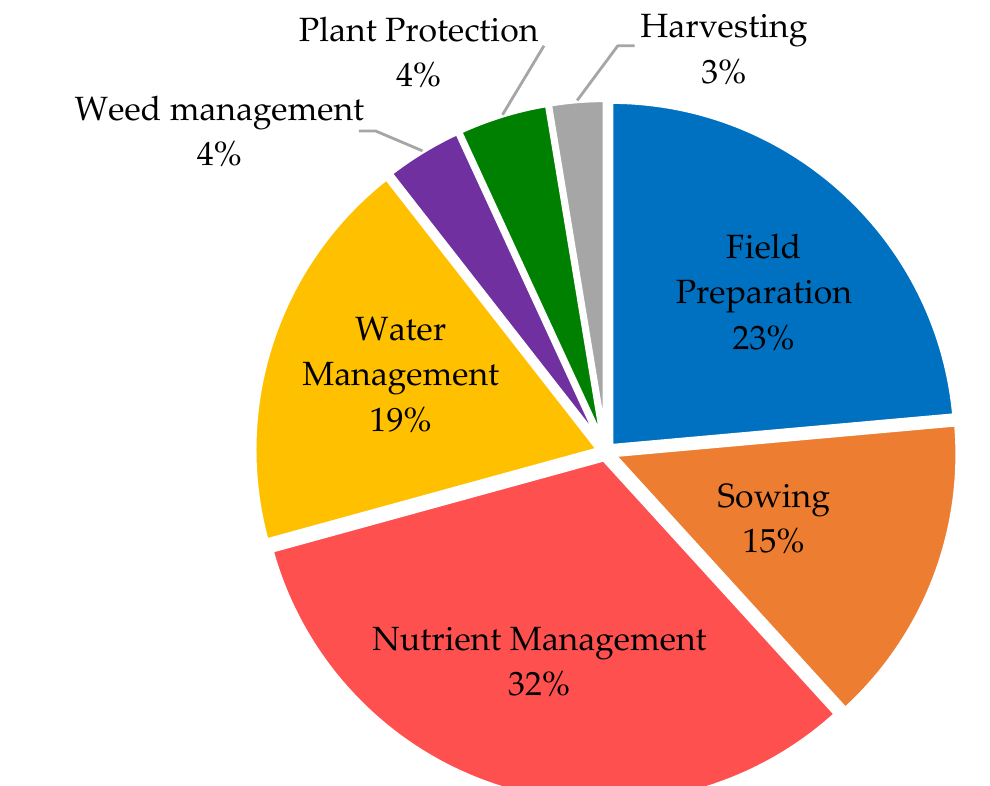
Figure 4. Operation-wise inputs energy (MJ ha −1 ) used for fodder maize varieties sown under different nutrient management practices (mean of two years).